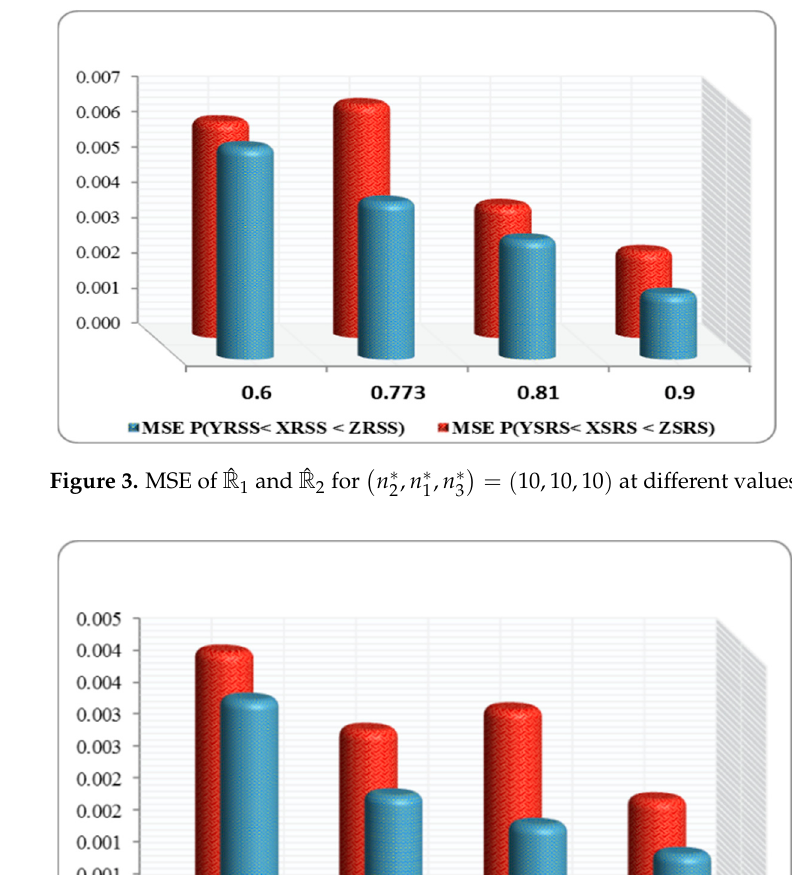
Figure 4. MSE of 1 ˆ  and Figure 4. MSE of ˆ R 1 and ˆ R 2 for